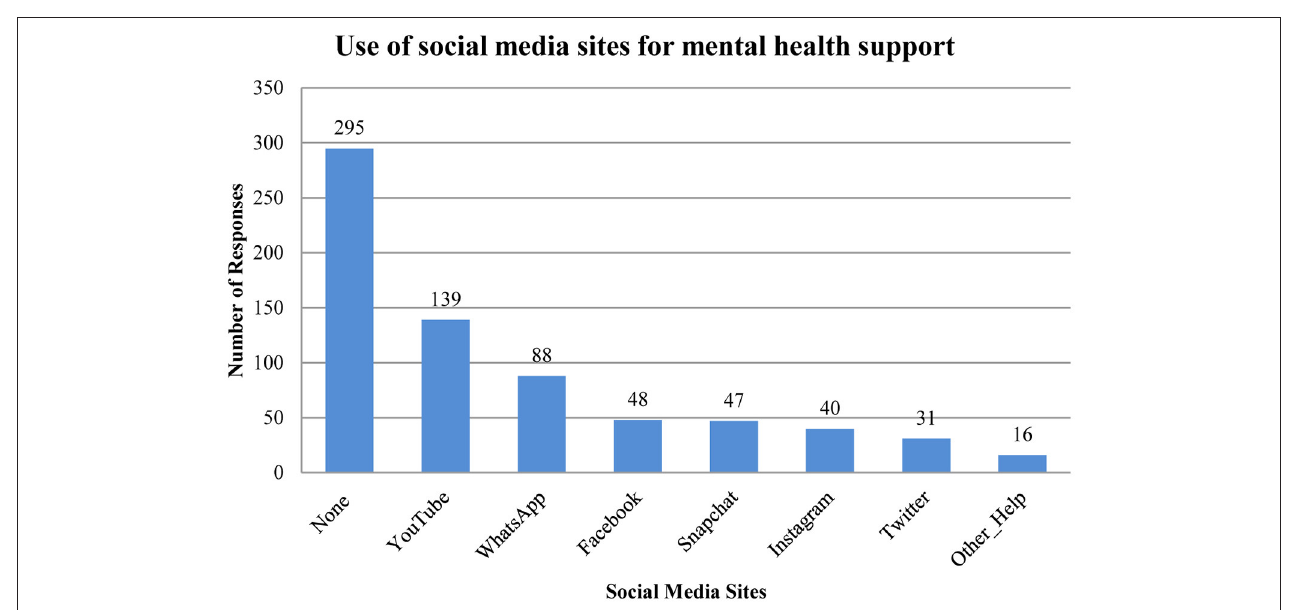
FIGURE 3 | Use of social media sites among the study cohort for mental health support. Number of responses, n =